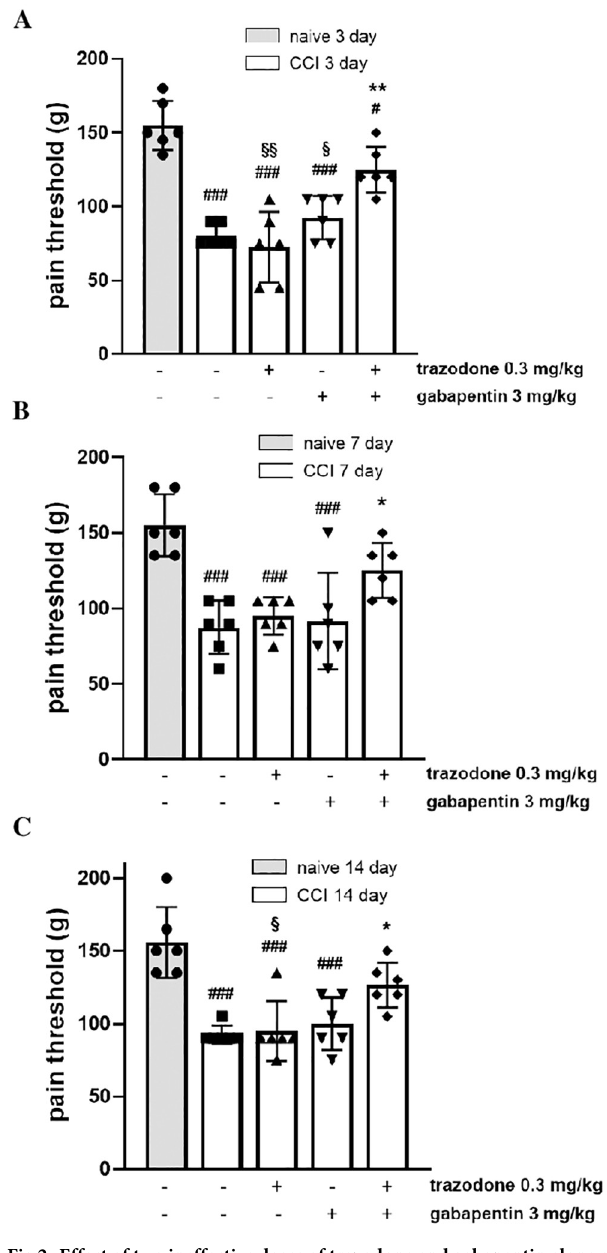
Fig 2. Effect of two ineffective doses of trazodone and gabapentin alone or in combination on mechanical hyperalgesia 3 (A), 7 (B) and 14 (C) days following rat sciatic nerve ligation. The results are expressed as pain threshold (in grams) recorded 1 h after treatment administration. ###P < 0.001 vs na ï ve group; � P < 0.05, �� P < 0.01 vs vehicle CCI group; §P < 0.05, §§P < 0.01 vs trazodone-gabapentin CCI group. n = 6